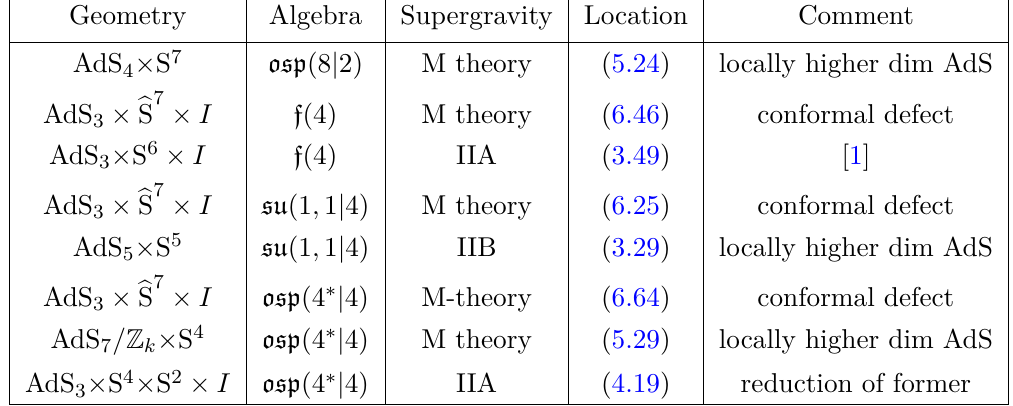
Table 1 . Summary of N = (8 , 0) solutions, the maximal d = 1 + 1 superconformal algebras they 7 preserve and where they are presented in the paper. Here b S represents a squashing of the 7-sphere and when I appears it is an interval over which the rest of the geometry is foliated. The higher- dimensional AdS spaces should be understood as foliations containing an AdS 3